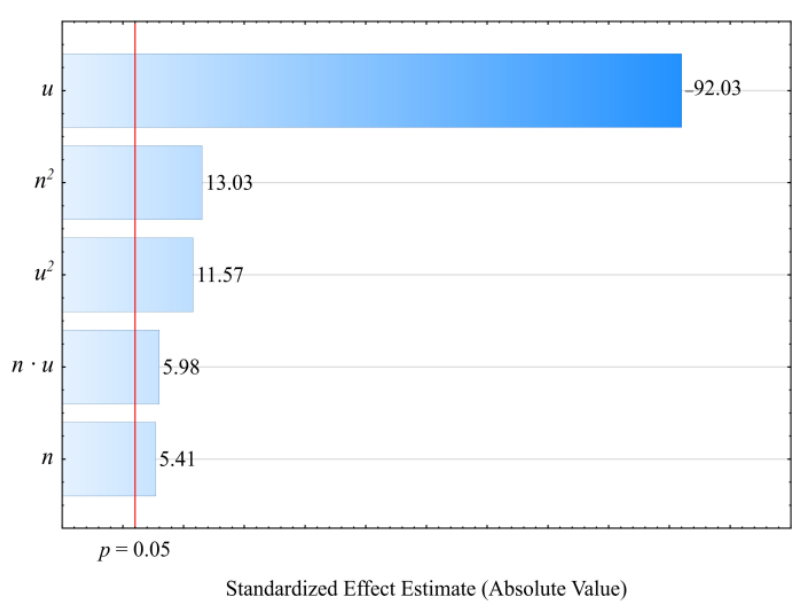
Figure 17. Pareto charts of the standardized effects for the empirical model of MFR ; the vertical line in the plot corresponds to the arbitrarily chosen level of significance ( p = 0.05).